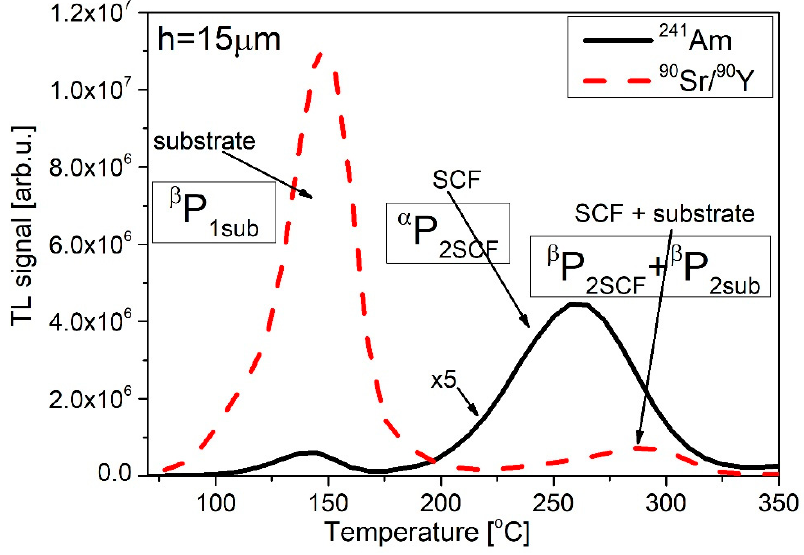
Figure 13. Schematic presentation of the relation between peaks, different parts of detectors, and type of ionizing radiation for LuAG:Ce SCF/YAG SC (sample #1).